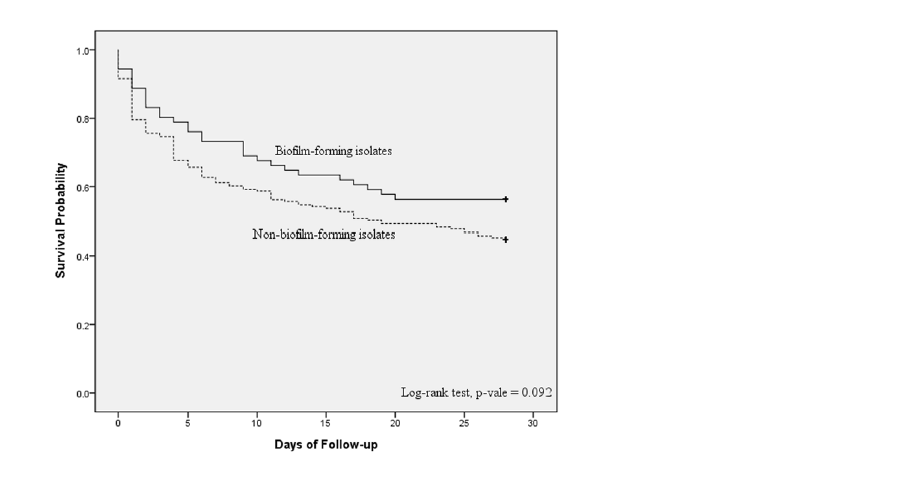
Figure 1. Comparison of Kaplan–Meier survival curves, at 28 days, between patients with Acinetobacter baumannii bacteraemic pneumonia caused by either biofilm-formation isolates or non-biofilm-formation isolates.